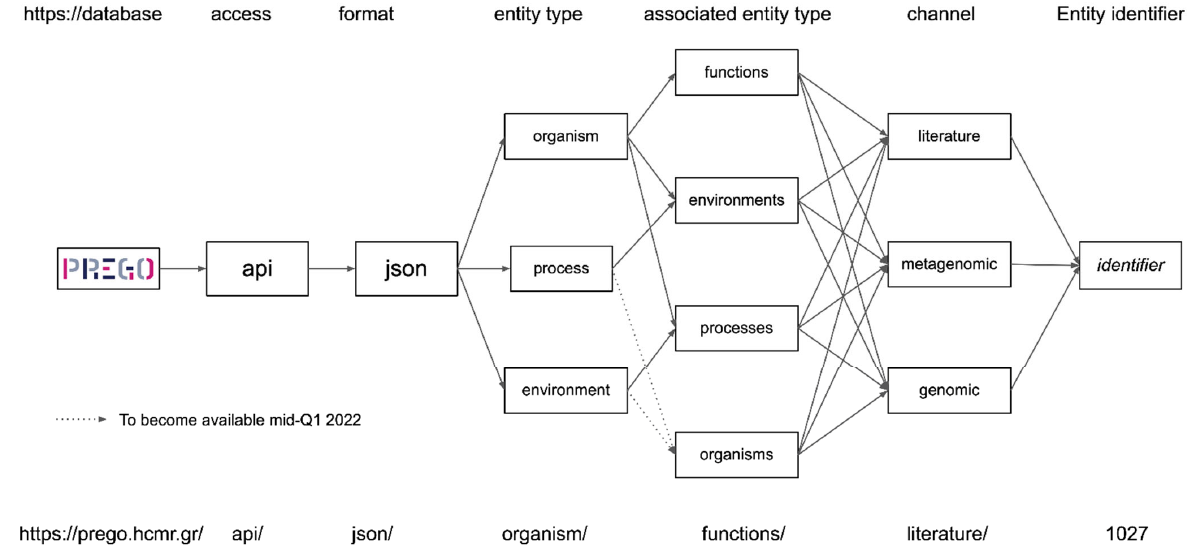
Figure 4. The PREGO API schema.